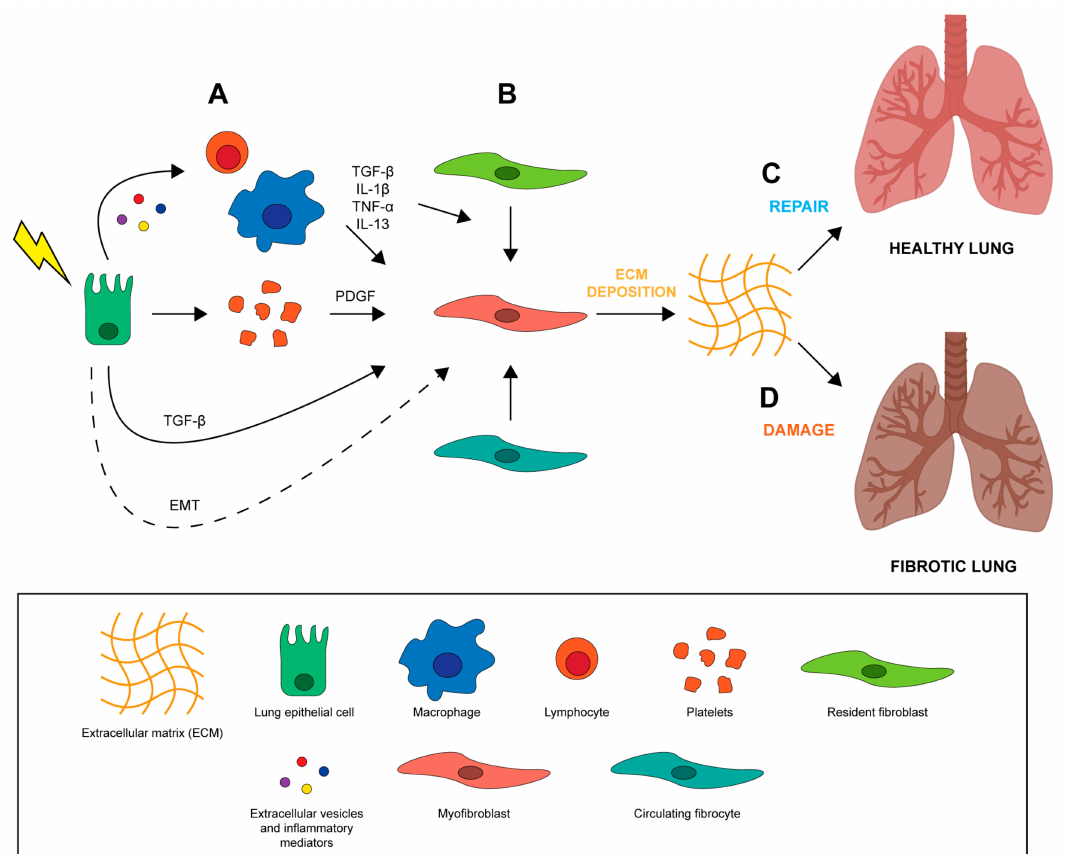
Figure 1. Alterations in normal wound healing processes promote the development of pulmonary fibrosis. ( A ) After radiation injury epithelial cells release inflammatory mediators, triggering platelet aggregation and inflammatory cell recruitment and activation. ( B ) Pro-fibrotic and inflammatory cytokines released by recruited immune cells, such as macrophages and lymphocytes, promote the recruitment and di ff erentiation of resident fibroblasts and circulating fibrocytes into ECM-secreting myofibroblasts. Fibroblasts and myofibroblasts may also originate from epithelial cells that have gone through the EMT process. ( C ) Activated myofibroblasts remodel ECM, actively promoting tissue repair by epithelial and endothelial cells and restoring lung function. ( D ) Disregulation of wound healing process and persisted inflammatory environment promote lung tissue fibrosis